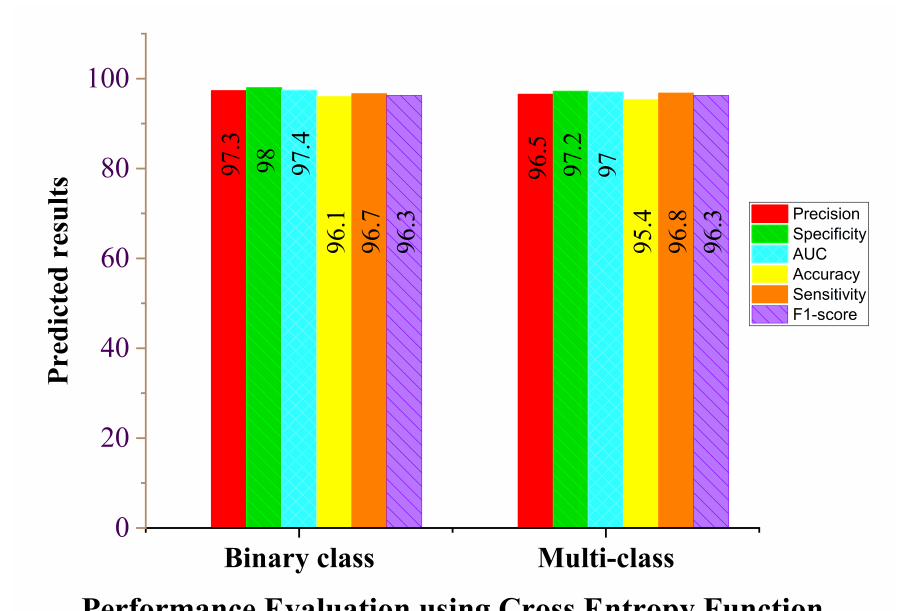
Figure 6. Cross-entropy loss function report for binary class and